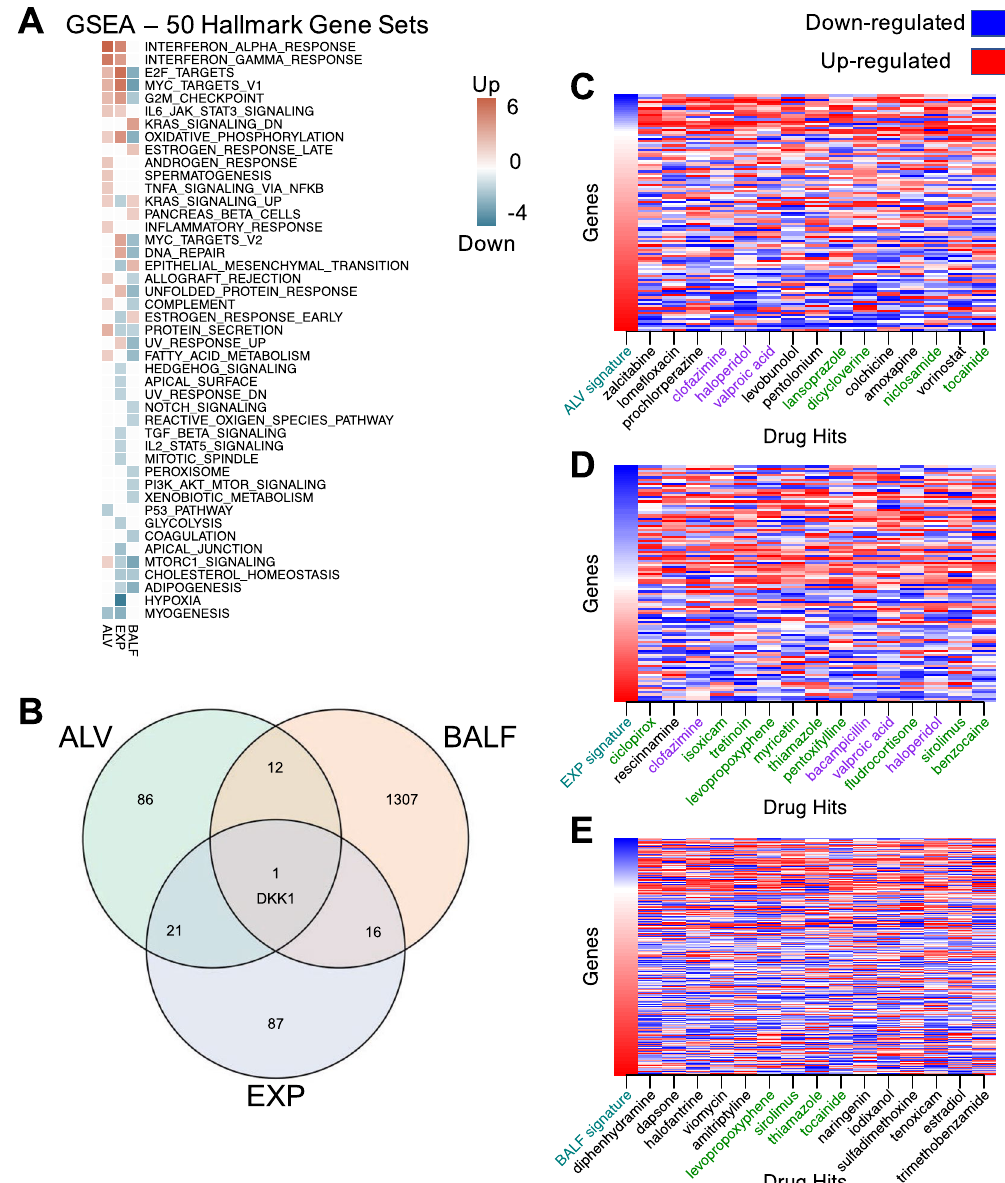
Figure 2. SARS-CoV-2 differential gene expression signatures reversed by drug profiles from CMap. ( A ) Enrichment analysis using GSEA reveals common pathways among input signatures. ( B ) DEG overlap from input signatures. Only 1 gene, DKK1, was shared by all 3 signatures. ( C ) Top 15 drug profiles reversing the ALV signature (109 genes). For each column, the gene expression values were ranked, with rank 1 being the most up-regulated gene (in red) and the maximum rank (109 for ALV) being the most down-regulated gene (in blue). Drug names highlighted in green were hits for a second signature, and drug hits highlighted in purple reversed all three signatures. ( D ) Top 15 drug profiles reversing the EXP signature (108 genes). ( E ) Top 15 drug profiles reversing the BALF signature (941